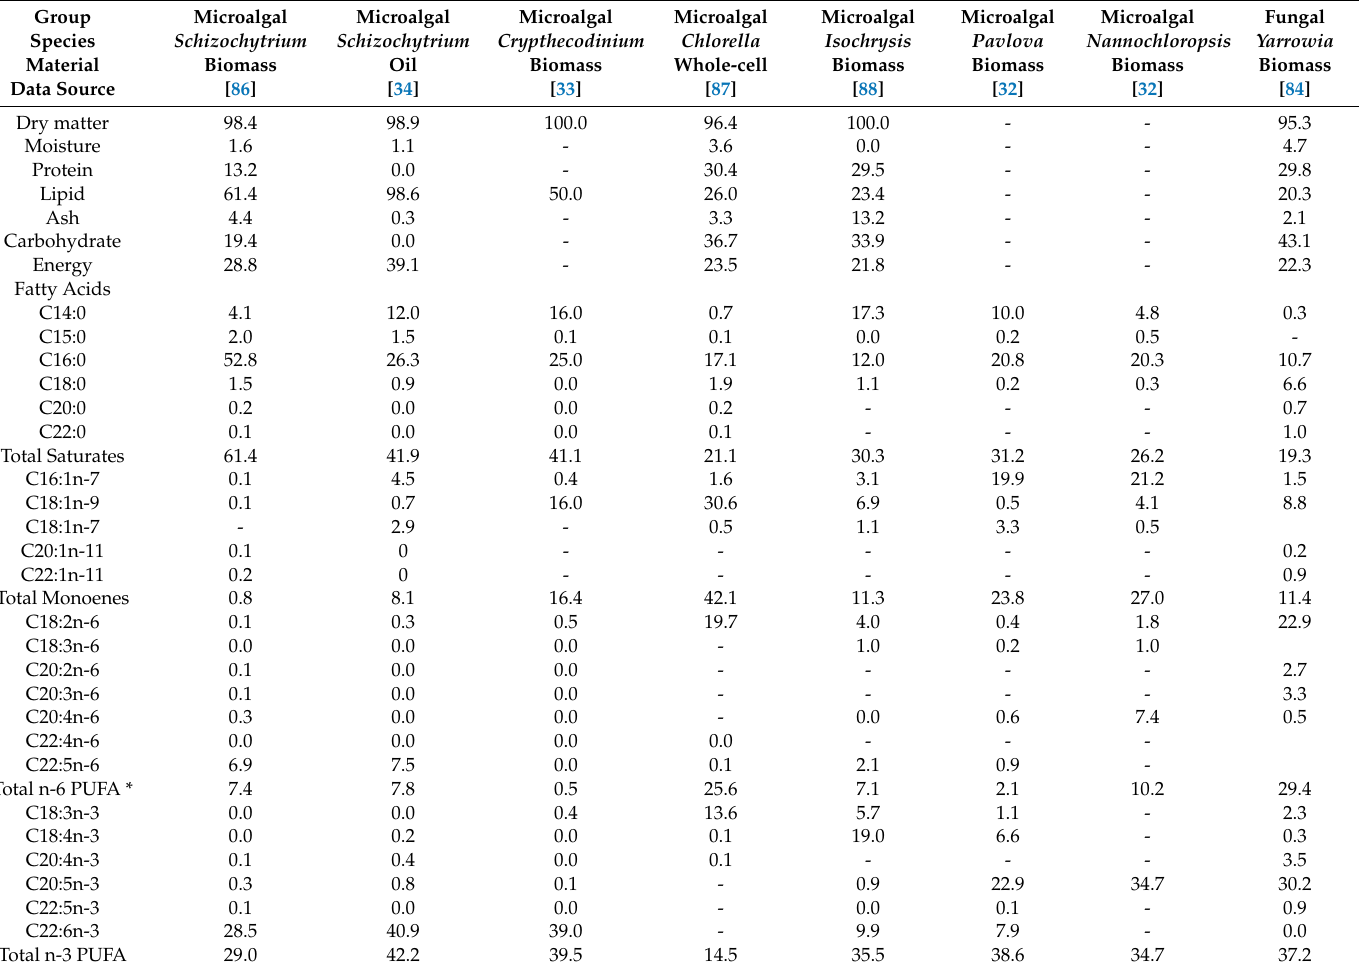
Table 3. Total lipid and fatty acid profiles (% of total fatty acids) of various SCO